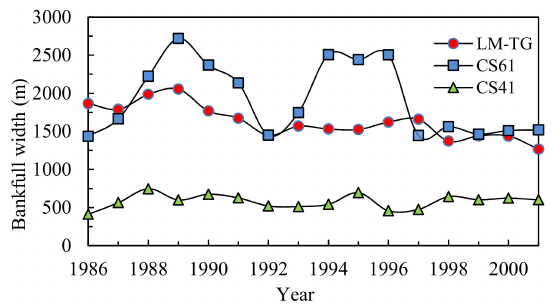
Figure 5. Temporal variations in the bankfull width at the typical sections of CS41 and CS61 and the reach-scale bankfull width in the Xiaobeiganliu